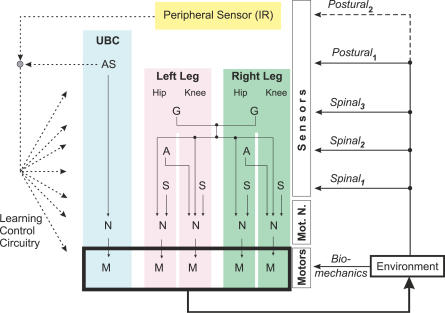
The Neuronal Control Structure of RunBotThe different reflexive control levels of RunBot (solid lines). Also indicated is the influence of simulated plasticity (dashed lines), described in detail in Figure 11. The black box at the bottom represents RunBot's physical embodiment, colored boxes its neuronal control and sensor networks. Walking control arises from the interplay of the different sensori–motor loops (spinal, postural) implemented in RunBot together with its passive dynamic walking properties (biomechanics). G, ground contact sensor; A, stretch receptor for anterior extreme angle of the hips; S, local angle sensor neuron of hips and knees; N, motor neuron (Mot.N.); M, motor. For details of the agonistic–antagonistic wiring, see Figure 6.